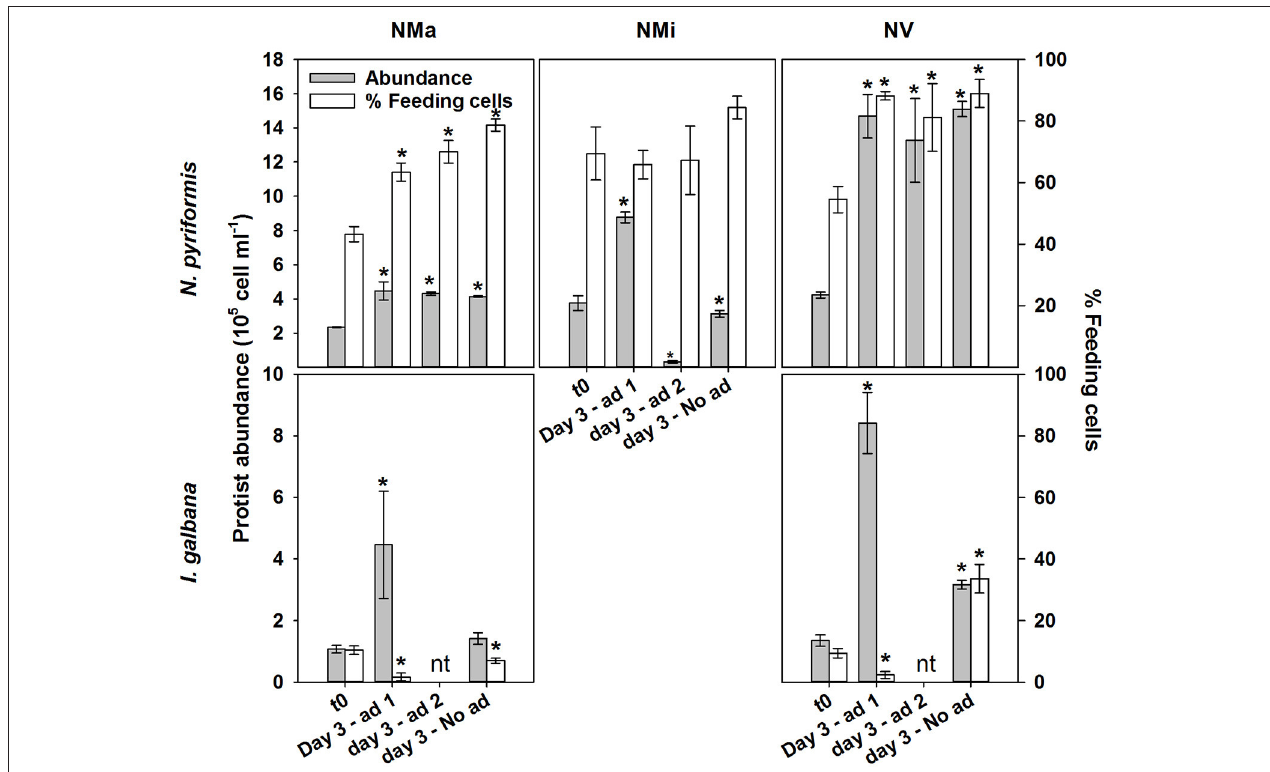
FIGURE 2 | Follow up experiments ascertaining the regulatory role of the “limiting” substrate on algae growth and feeding. These were conducted with the N. pyriformis and I. galbana treatments NMa, NMi and NV. Ad 1, addition 1 - addition of the “limiting” solution (e.g., vitmains to the NV treatment); Ad 2, addition 2 - addition of the other solutions (e.g., macro- and micronutrients to the NV treatment); No ad, unamended treatment; nt, not tested. *Indicates significant differences to t0 ( t -test; P < 0.05).